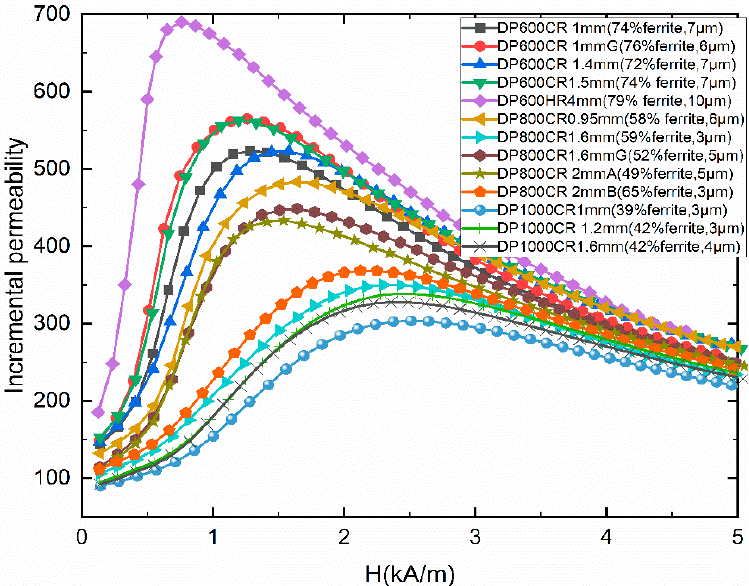
Figure 7. Incremental permeability versus applied magnetic field for the commercial DP600, DP800 and DP1000 steel samples.